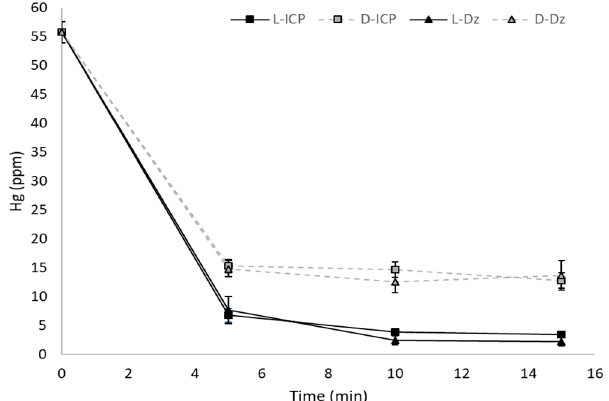
Figure 2. Comparison of Hg quantification with ICP-OES. Data of L. sphaericus III(3)7 treatment. L: Live; D: Dead.